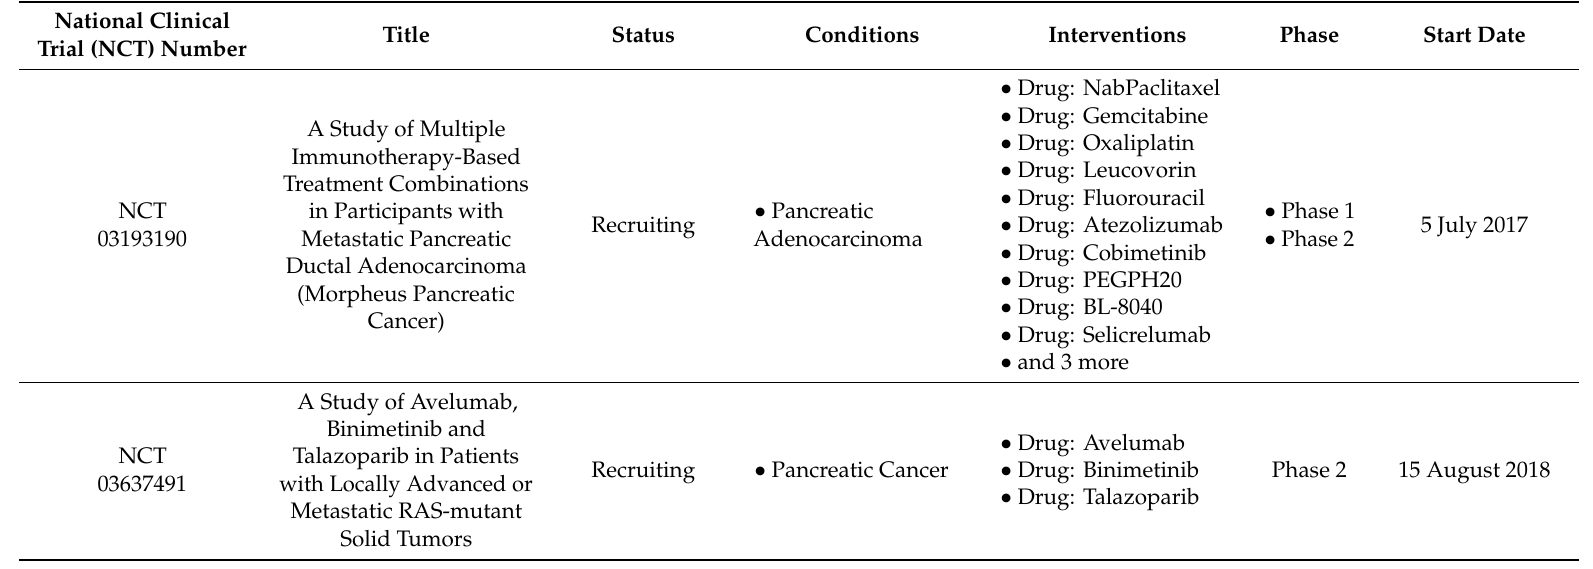
Table 9. Clinical trials of therapies targeting the MAPK pathway and immunotherapies in patients with pancreatic